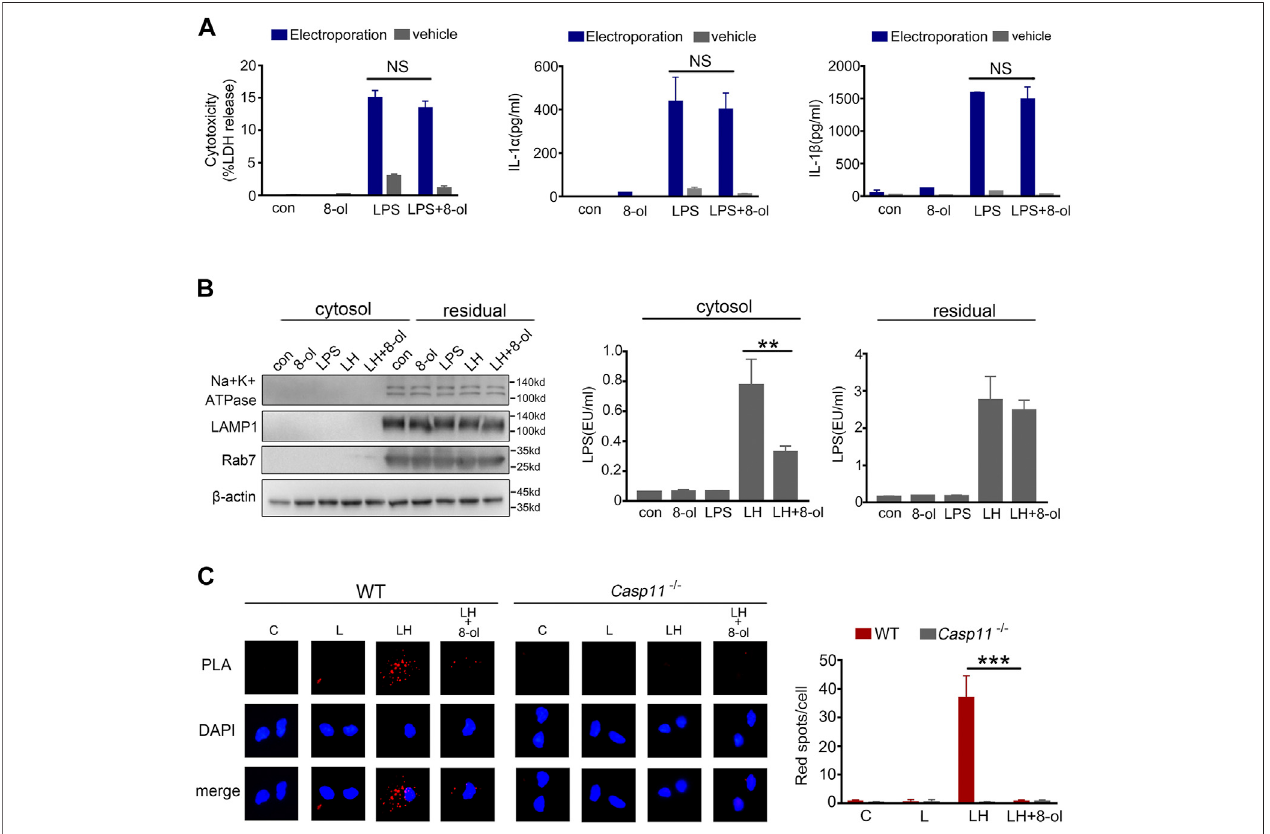
FIGURE 4 | 8-ol prevents HMGB1-mediated cytoplasmic translocation of LPS. (A) LDH, IL-1 α , and IL-1 β release from mouse peritoneal macrophages upon LPS stimulation with or without 8-ol electroporation. (B) Western blots for Na + /K + ATPase, LAMP1, Rab7, and β -actin, LAL assay for LPS (EU, endotoxin units) in the cytoplasmicandresidualfractionsofmouseperitonealmacrophagestreatedwithLPSalone(1 μ g/ml)orLPS(1 μ g/ml)+HMGB1 (400 ng/ml)withorwithout8-olfor2 h. (C) Physical interaction between LPS and caspase-11 was visualized as red spots using the proximity-ligation assay (PLA). Mouse peritoneal macrophages were primedwithLPS(100 ng/ml)for4 handthenstimulatedwithLPS(1 μ g/ml)orLPS(1 μ g/ml)+HMGB1(400 ng/ml)withorwithout8-olfor2 h.Graphsshowthemean ± SD of technical replicates and are representative of at least three independent experiments. * p < 0.05; ** p < 0.01; *** p < 0.001, NS: not signi fi